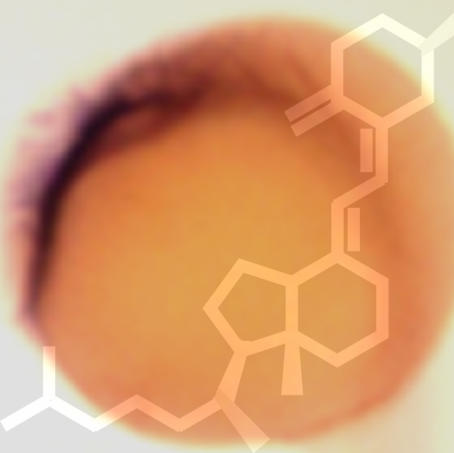
Structure of the vitamin D3 molecule overlaying a photograph of a zebrafish embryo stained for hedgehog pathway activity.